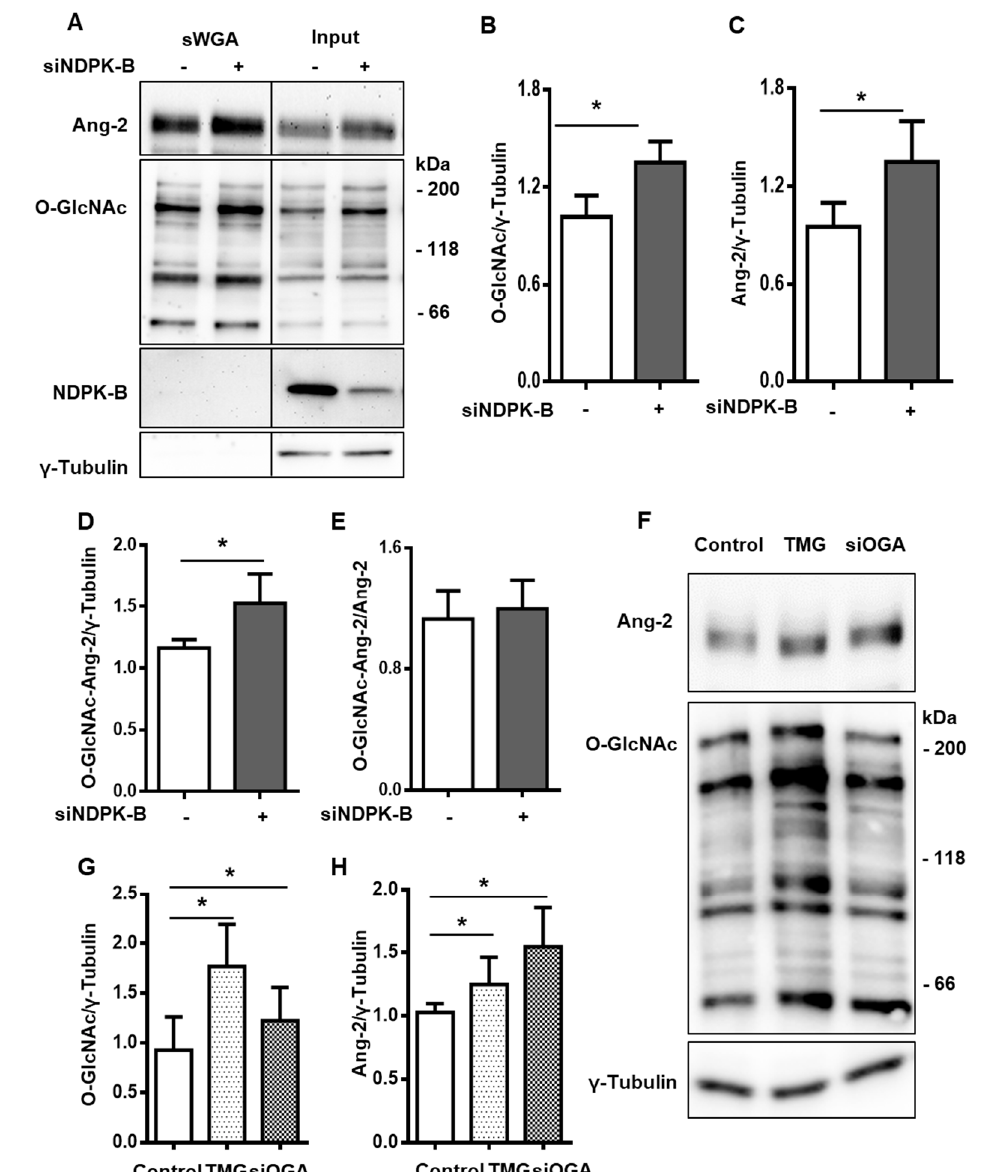
Figure 5. Elevation of O-GlcNAcylation by the suppression of OGA activity regulates Ang-2 expression. ( A ) HUVECs were transfected with either scrambled control ( − ) or siRNA against NDPK-B (siNDPK-B, + ) and O-GlcNAcylated proteins were precipitated from the lysates using s-WGA beads. Precipitates (s-WGA) and whole cell lysates (Input) were subjected to immunoblotting and probed for Ang-2, O-GlcNAc, NDPK-B, and γ -Tubulin (n = 4). Quantification of ( B ) protein O-GlcNAcylation, ( C ) Ang-2, and ( D ) O-GlcNAcylated Ang-2 in the precipitates relative to γ -tubulin in the input lysates. ( E ) Quantification of O-GlcNAcylated Ang-2 relative to Ang-2 in the input lysates. ( F ) HUVECs were transfected with either scrambled control or siRNA against OGA (siOGA), or treated with 10 µ M of the OGA inhibitor, TMG, for 24 h. Cell lysates were analyzed for Ang-2 and protein O-GlcNAcylation by immunoblot (n = 8). Quantification of ( G ) protein O-GlcNAcylation and ( H ) Ang-2 relative to γ -tubulin. S-WGA: succinylated WGA-bound agarose beads; TMG: Thiamet G; OGA: O-GlcNAcase. Results are presented as mean ± SD. *: p < 0.05.